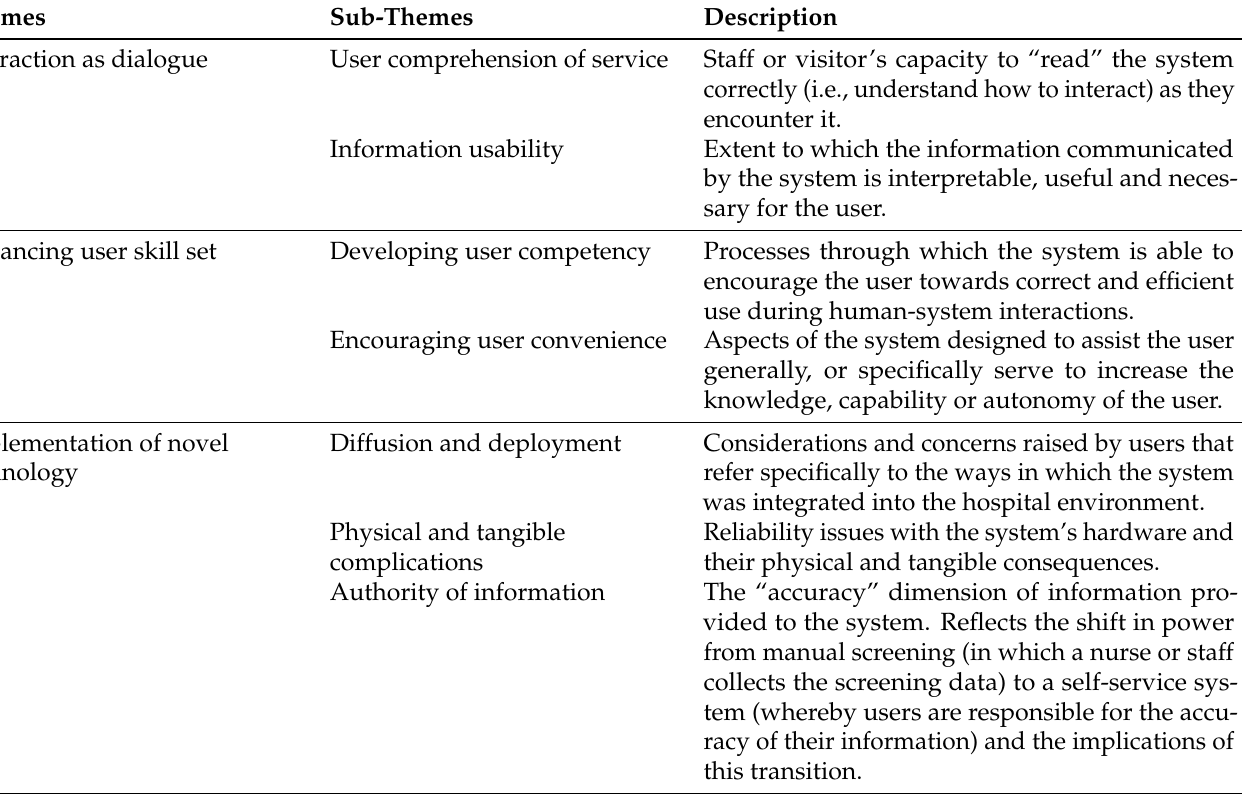
Table 3. Summary of the thematic analysis of staff and visitor’s experience with the